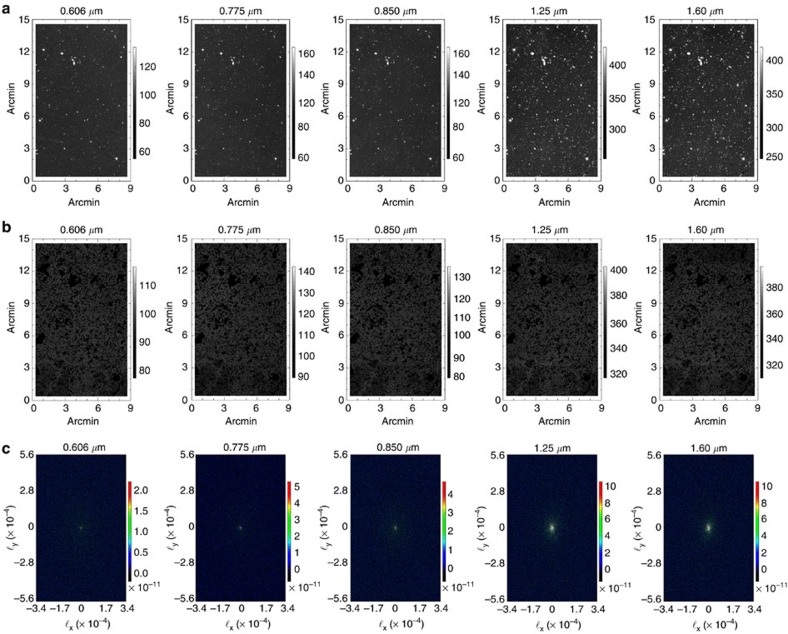
Self-calibrated mosaics.(a) GOODS-S SelfCal mosaics for each band. We astrometrically align each map and crop the outer regions so as to include only sections that have been observed in all five bands. The units of the maps are nW m−2 sr−1. (b) The same as a except with the source mask applied. (c) The fast fourier transform (FFT) of each of the maps in b which is what is used to measure the angular power spectrum. This is plotted in Fourier space as a function of modes ℓx and ℓy. The FFT of each map is structureless and contains only Gaussian noise, which is indicative of high-quality mosaics. By definition, the units of the FFT are the same as the units of the map. Each column is filter specific, plotted as 0.606, 0.775, 0.850, 1.25 and 1.60 μm.